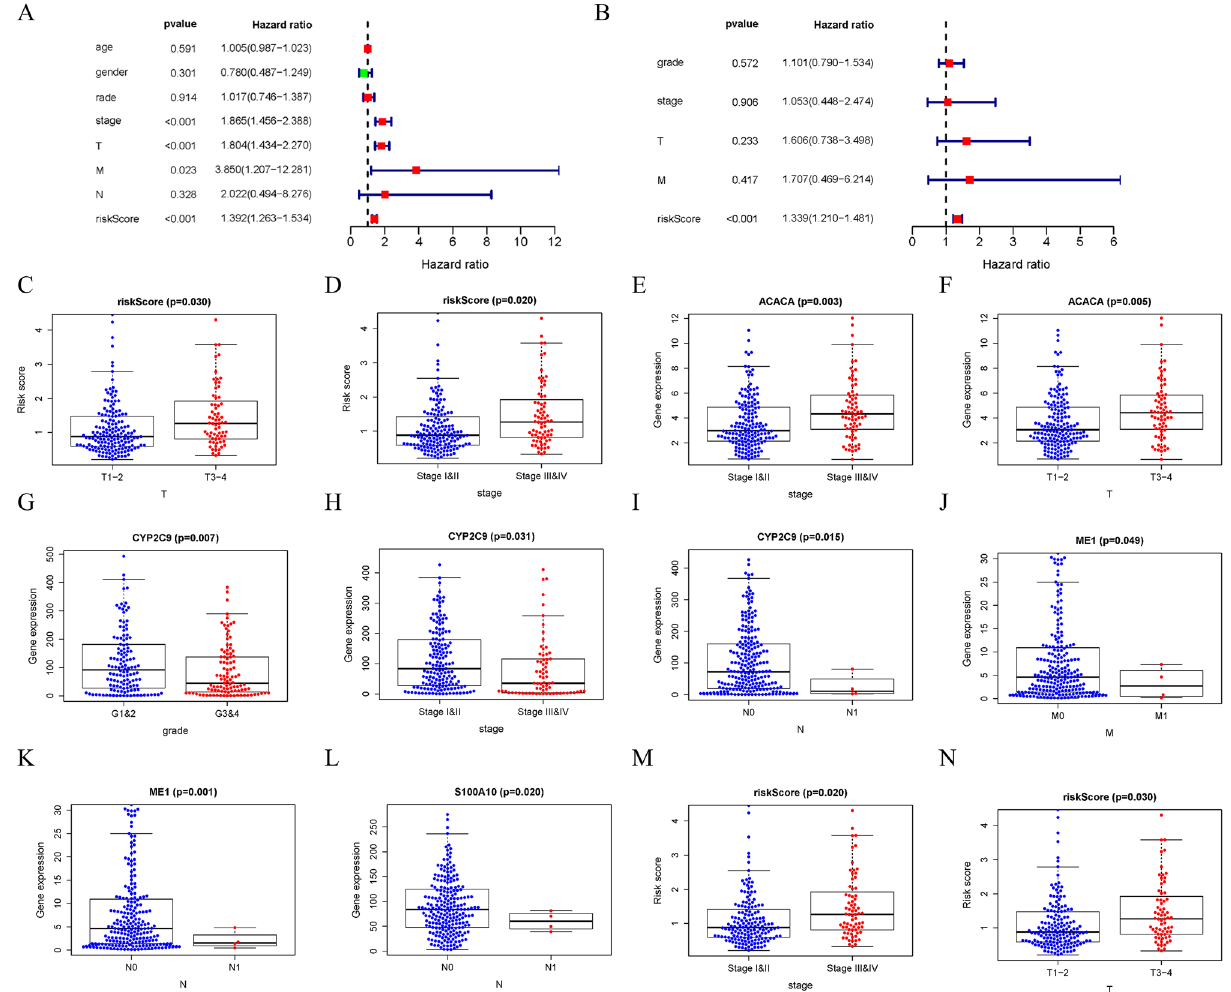
Figure 3. Risk score significantly correlated with patient prognosis and HCC pathological features. ( A ) Univariate Cox regression analysis of TCGA cohort. ( B ) Multivariate Cox regression analysis of TCGA cohort. ( C – N ) Relationship between risk score and gene expression and clinicopathological features of